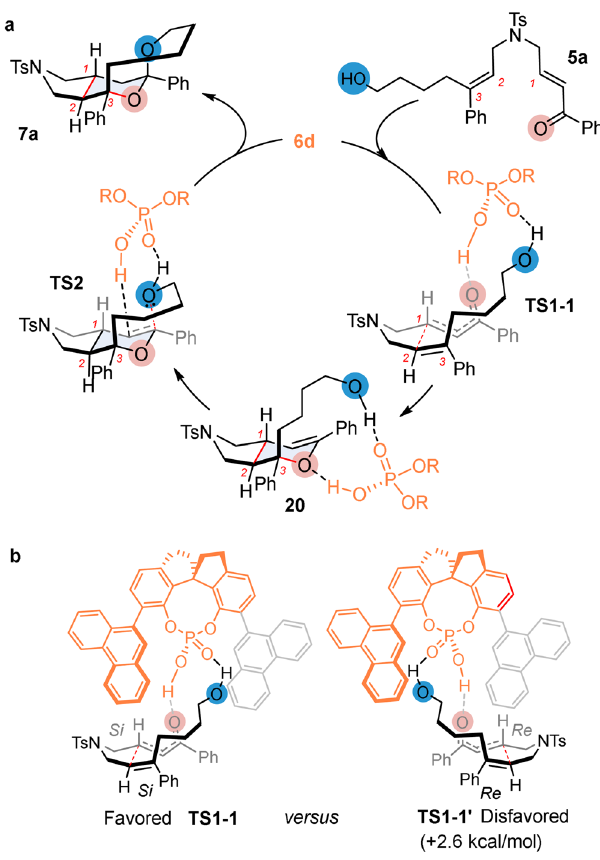
Fig. 7 Mechanistic proposal. a Proposed catalytic cycle. b Transition state model of